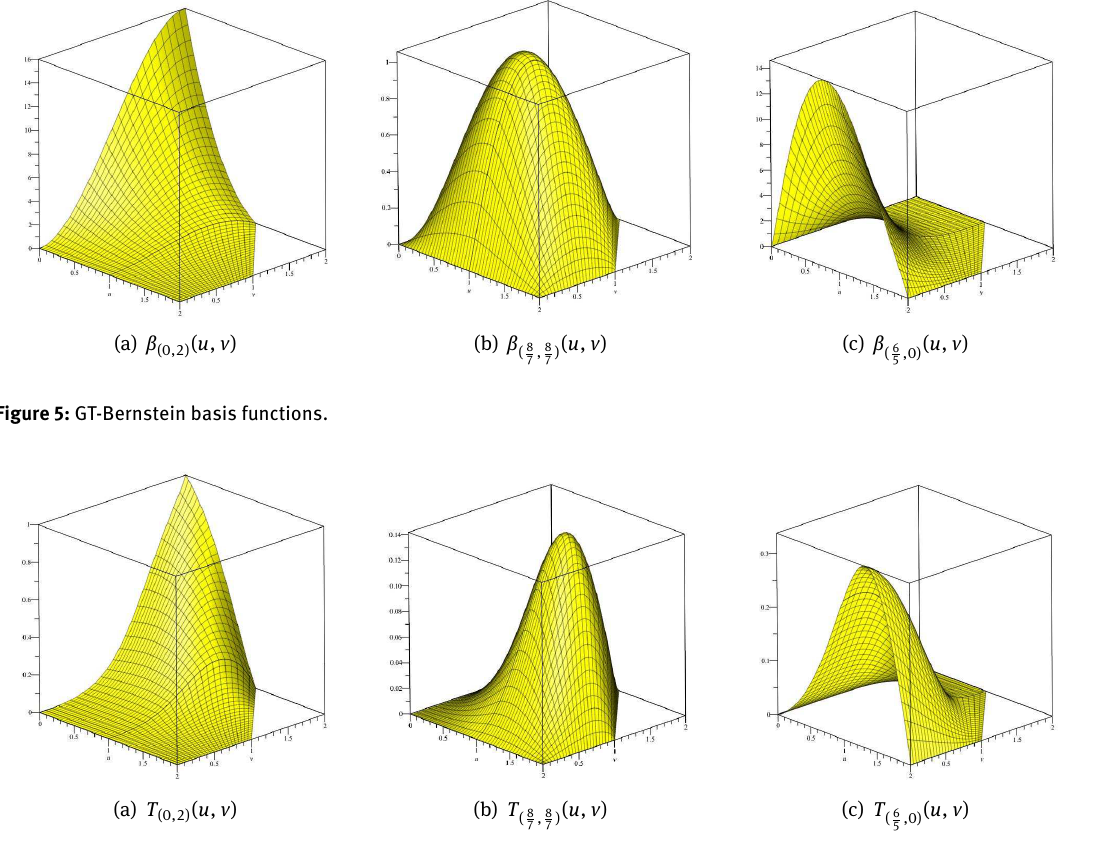
Figure 6: Rational GT-Bernstein basis